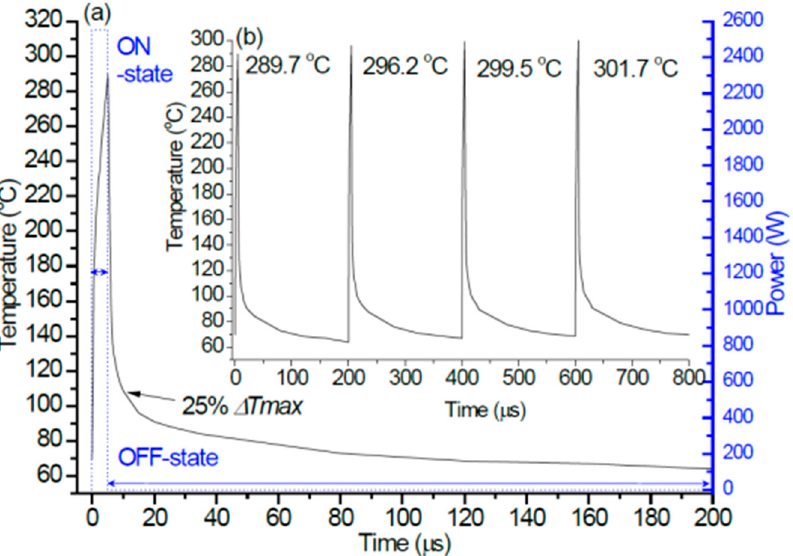
Figure 2. ( a ) Transient channel temperature with pulsed-mode power during one pulse period; ( b ) periodic transient pulses temperature